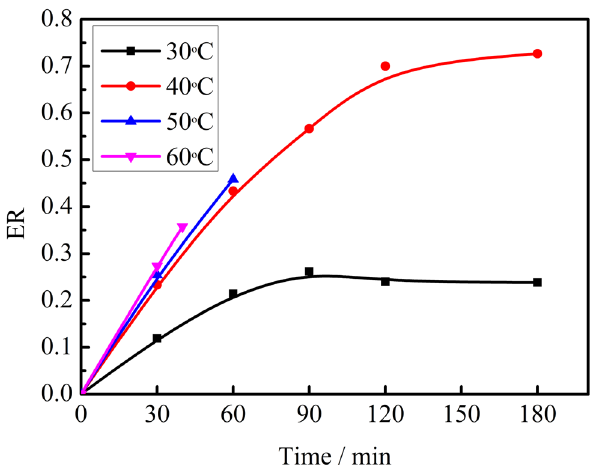
Figure 1: Swelling curves of LDPE under di ff erent temperatures and times.